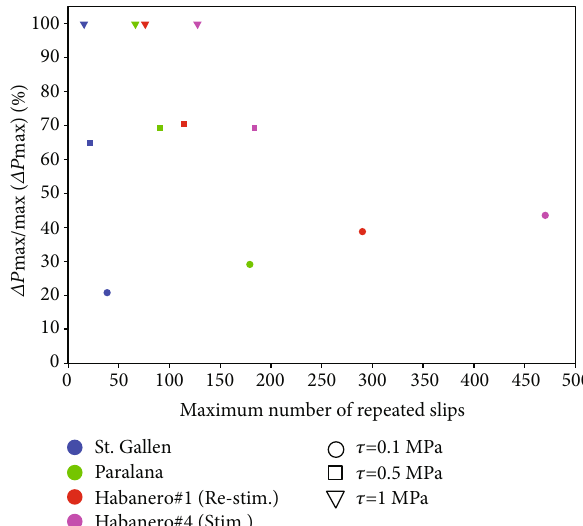
Figure 15: Percentage of maximum cumulative fl uid pressure change for di ff erent stress drop models as a function of the maximum number of repeated slips for the three geothermal projects mentioned here (St. Gallen, Paralana, Habanero#1- restimulation) and the Habanero#4-stimulation analysed in Baisch